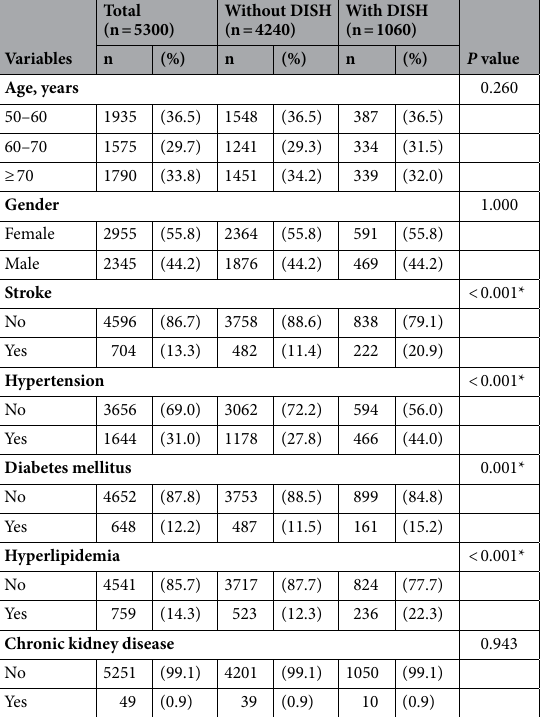
Table 1. Clinical characteristics of study subjects with and without diffuse idiopathic skeletal hyperostosis. DISH diffuse idiopathic skeletal hyperostosis. * p <